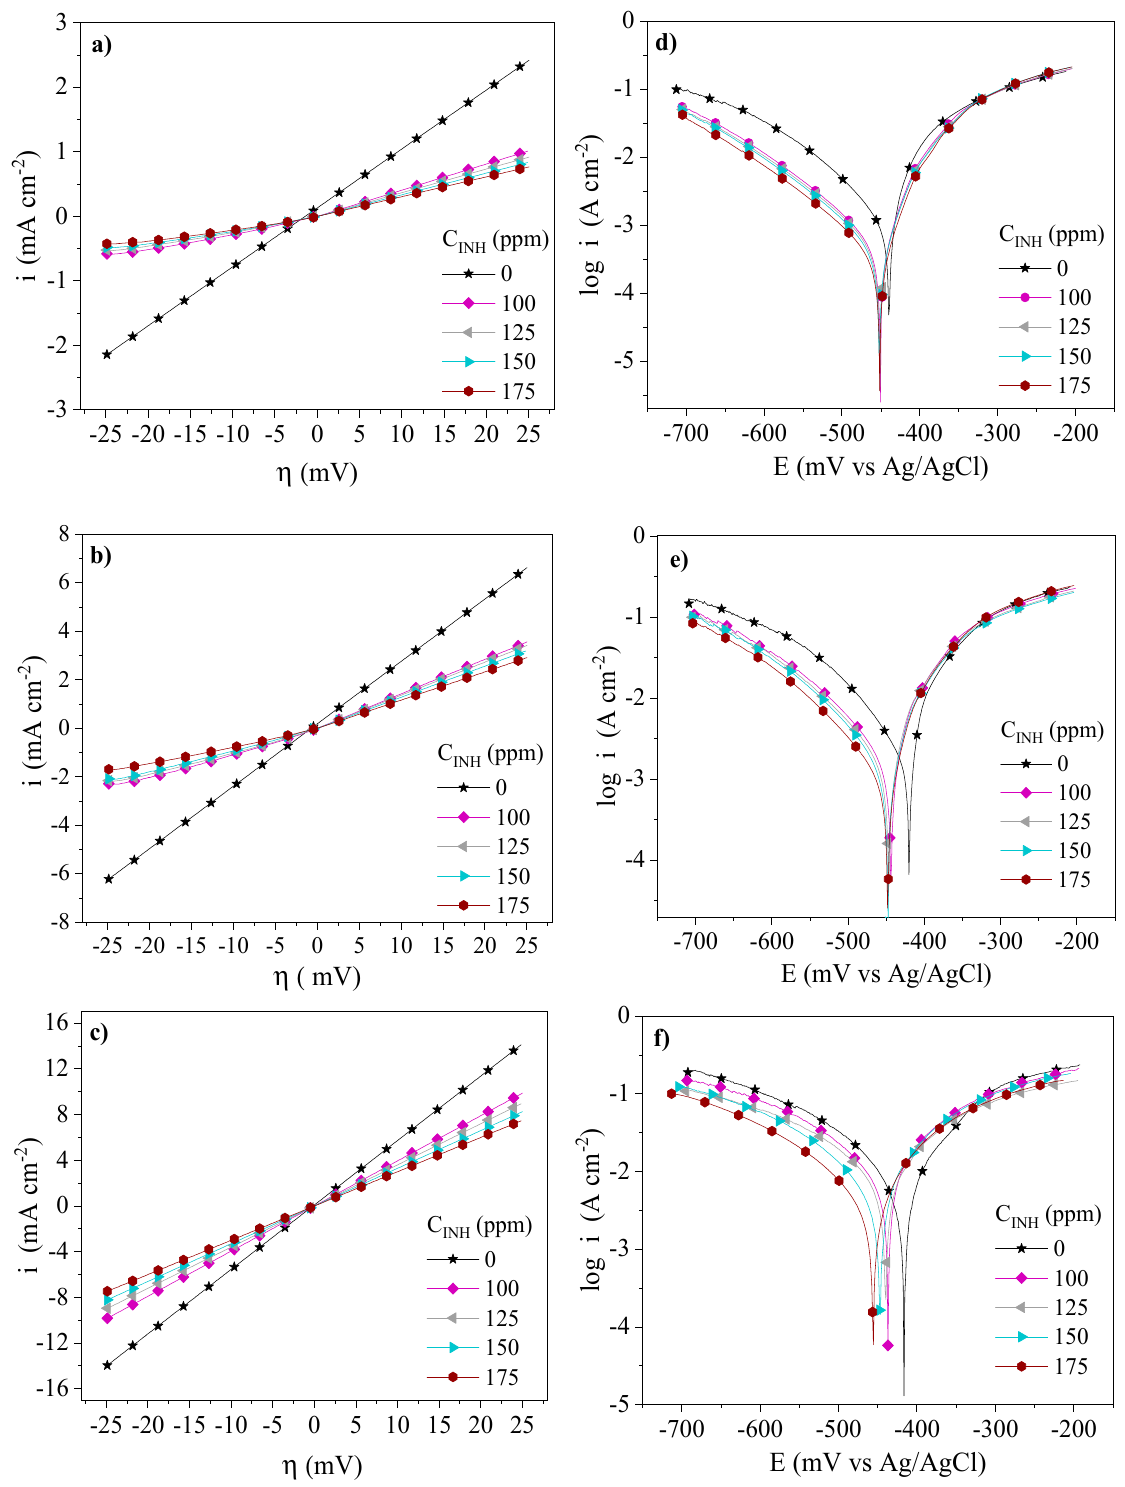
Figure 4. Electrochemical behavior of Poly[VIMC2][Br] as CI of API 5L X60 steel in 1 M H 2 SO 4 by the LPR and PDP techniques: ( a ) LPR—308 K, ( b ) LPR—318 K, ( c ) LPR—328 K, ( d ) PDP—308 K, ( e ) PDP—318 K and ( f ) PDP—328 K.